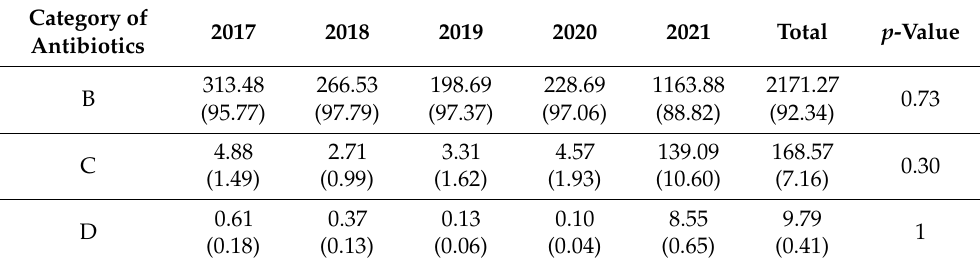
Table 4. Prescribed antibiotics by FDA category expressed in DDDs/100 bed days.